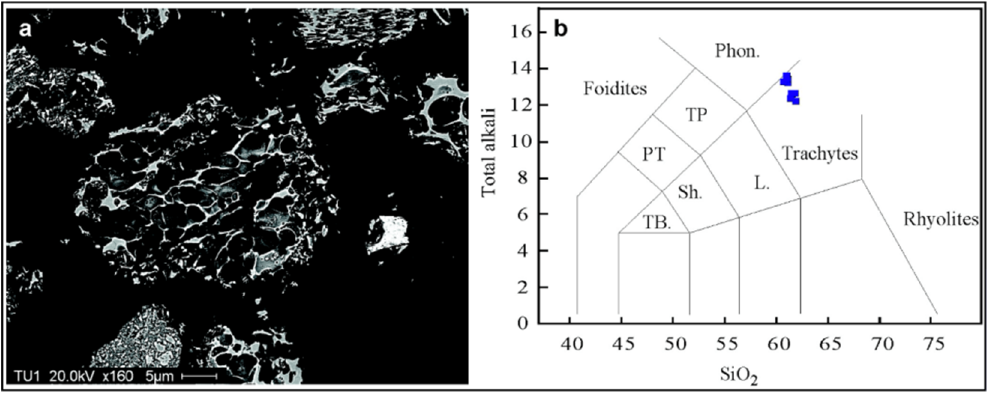
Figure 10. Electronic microscope photo of the ash clasts sampled in the TU1 tephra ( a ). TAS classification diagram of the EDS ash composition ( b ).